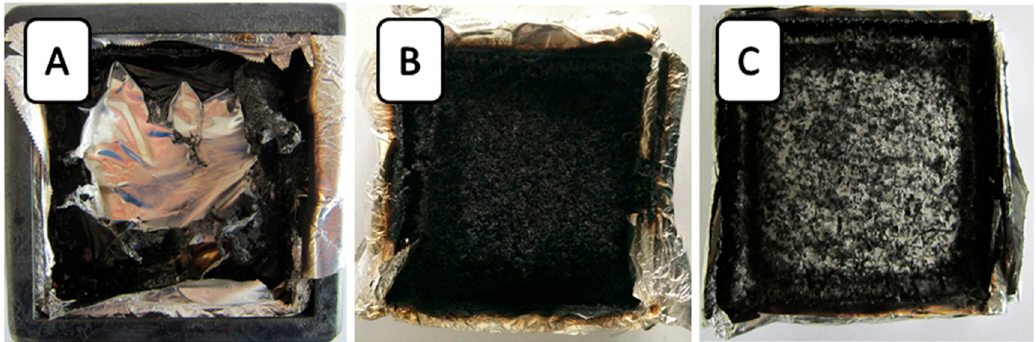
Figure 3. Digital photos of residues from the cone calorimeter test. ( A ) Neat RPUF; ( B ) 14AO/14B/6E/PU; ( C ) 14ATH/14B/6E/PU.